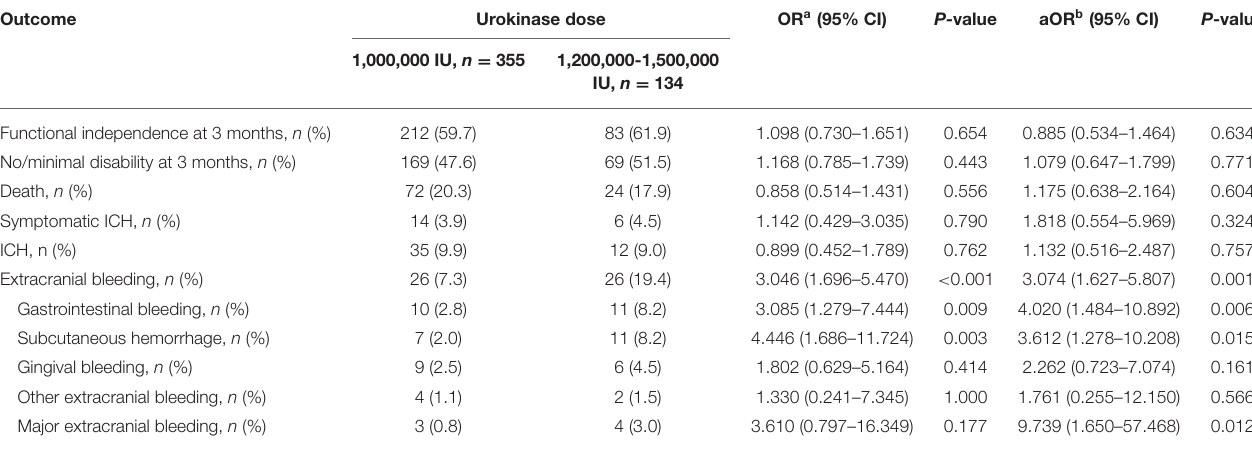
TABLE 3 | Outcomes and treatment complications by urokinase dose. Outcome